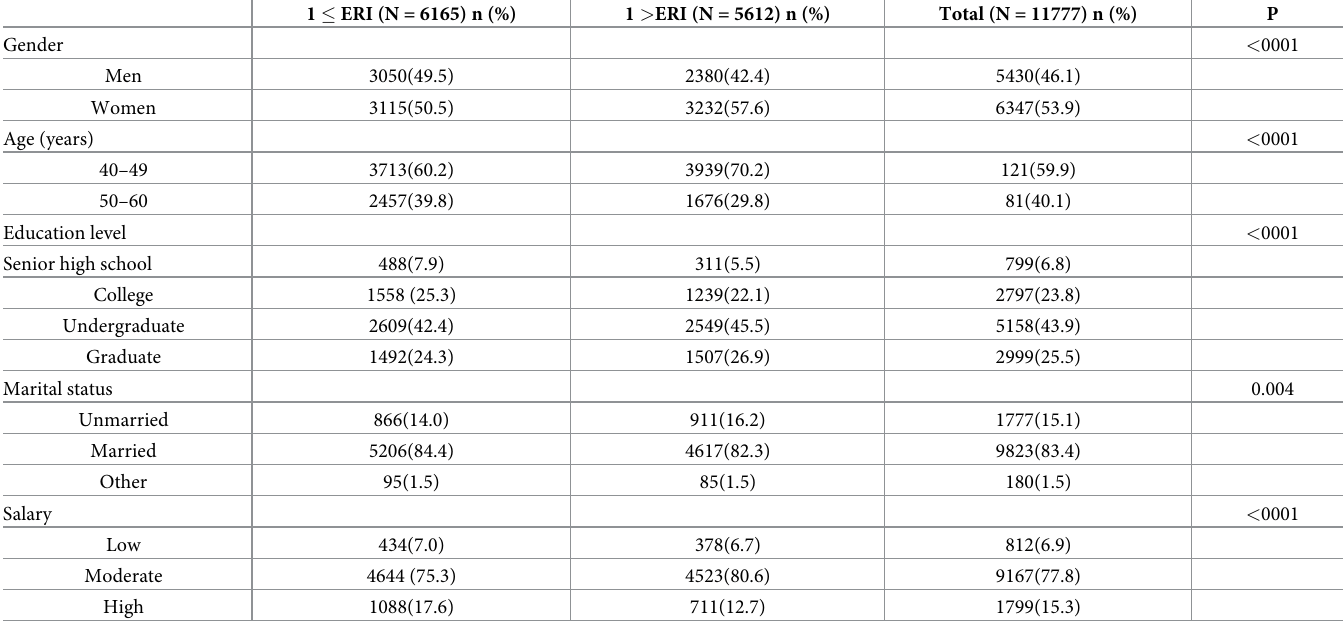
Table 1. Demographic information for both ERI